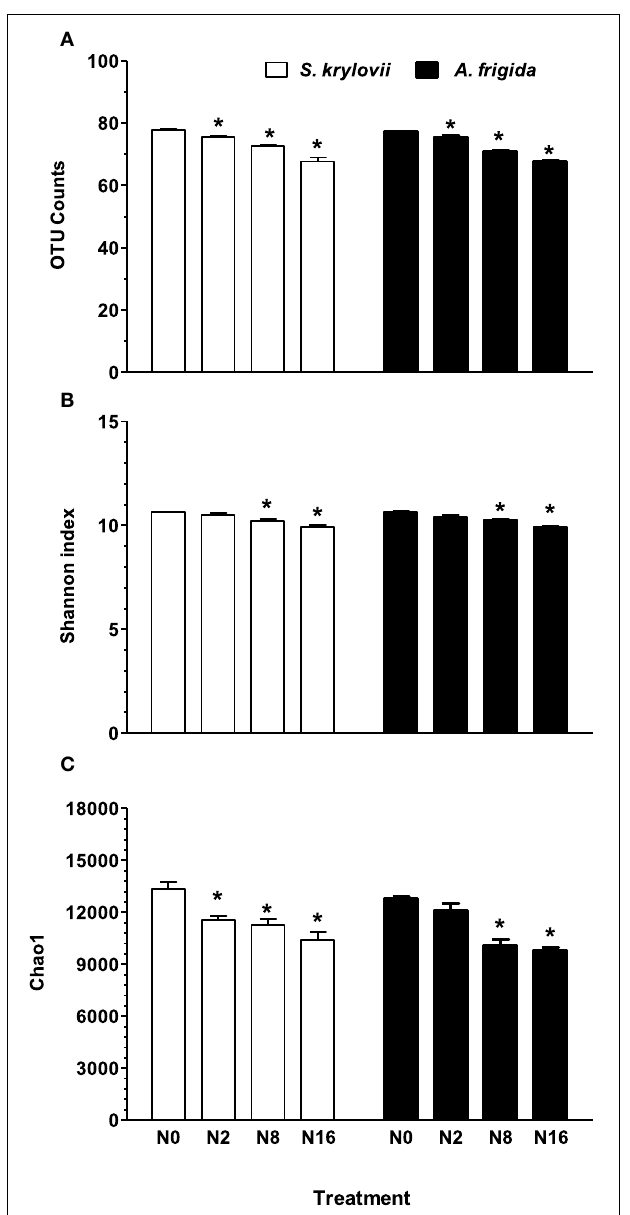
FIGURE 3 | Estimated number of observed (A) OTU counts, (B) Shannon index, (C) Chao1 index of S. krylovii and A. frigida rhizosphere microbiome across all the N-supplied plots. Data are means ± s.e. ( n = 3 ). Asterisks on the top of columns indicate significant difference at P < 0.05 between N0 and different rates of N addition for each